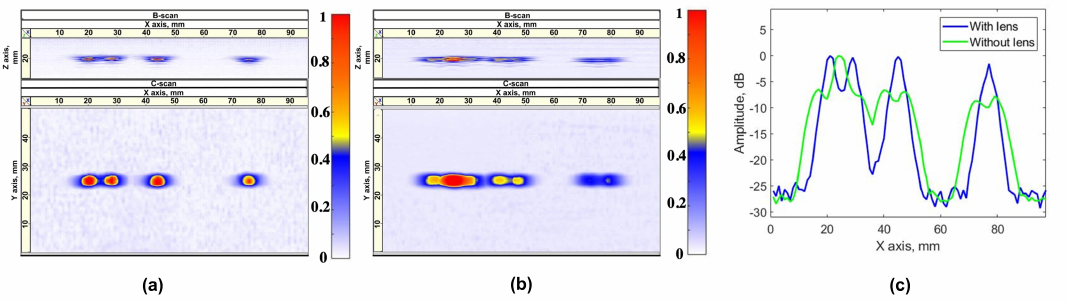
Figure 12. Two projections of obtained volumetric result for the block D, ( a ) with PR-FZP, and ( b ) without PR-FZP. ( c ) Lateral profile of result obtained for block D on the X